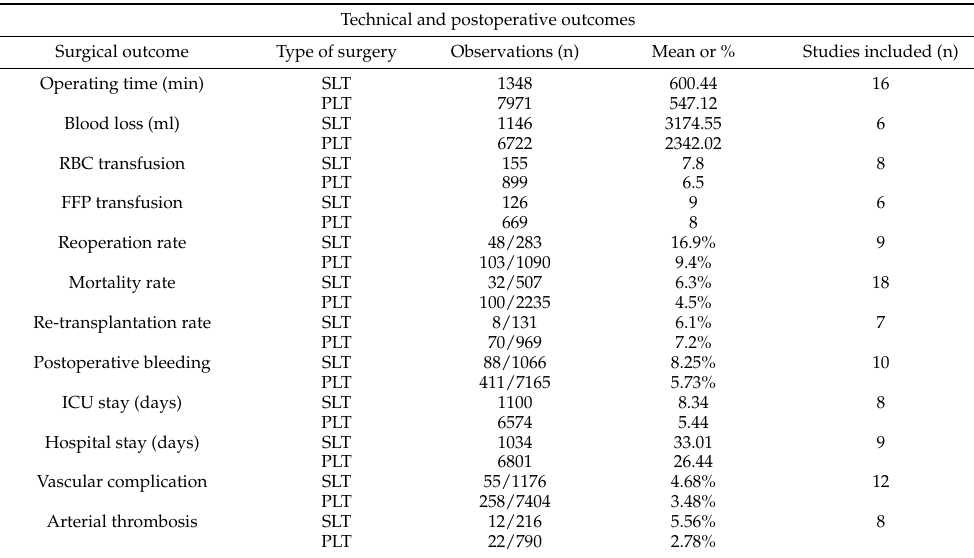
Table 3. Technical and postoperative outcomes; Oncological and survival